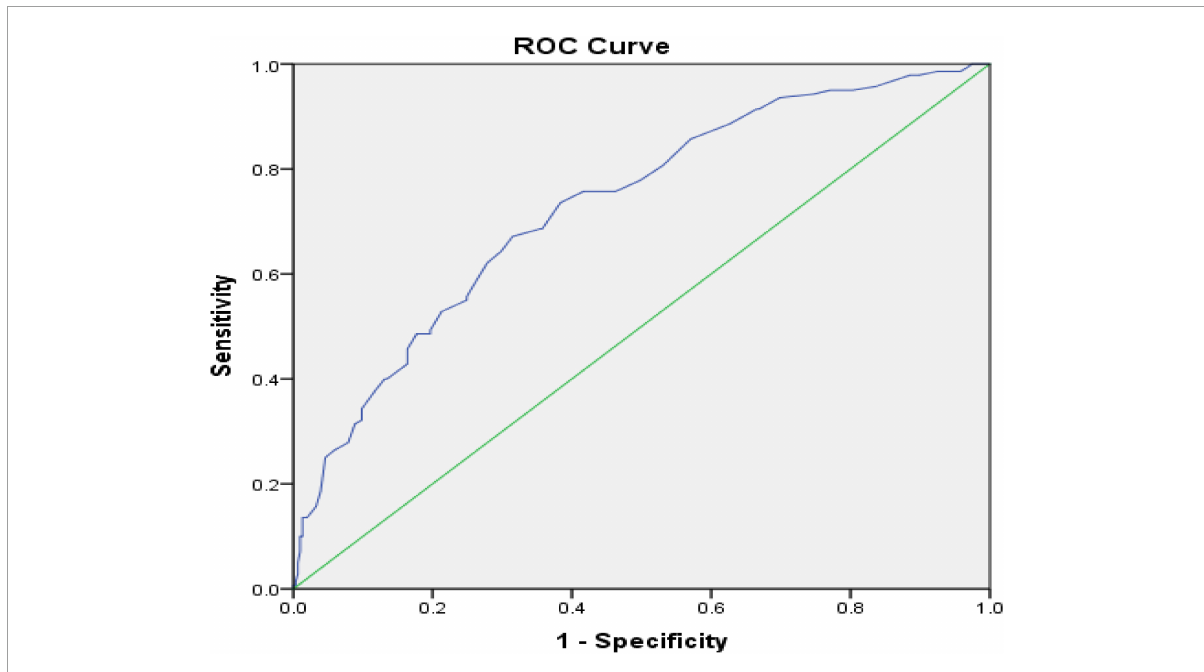
FIGURE2 ROC Curve with Reference Line on the Persian Version of the Moral Injury Symptoms Scale-Health Care Professionals